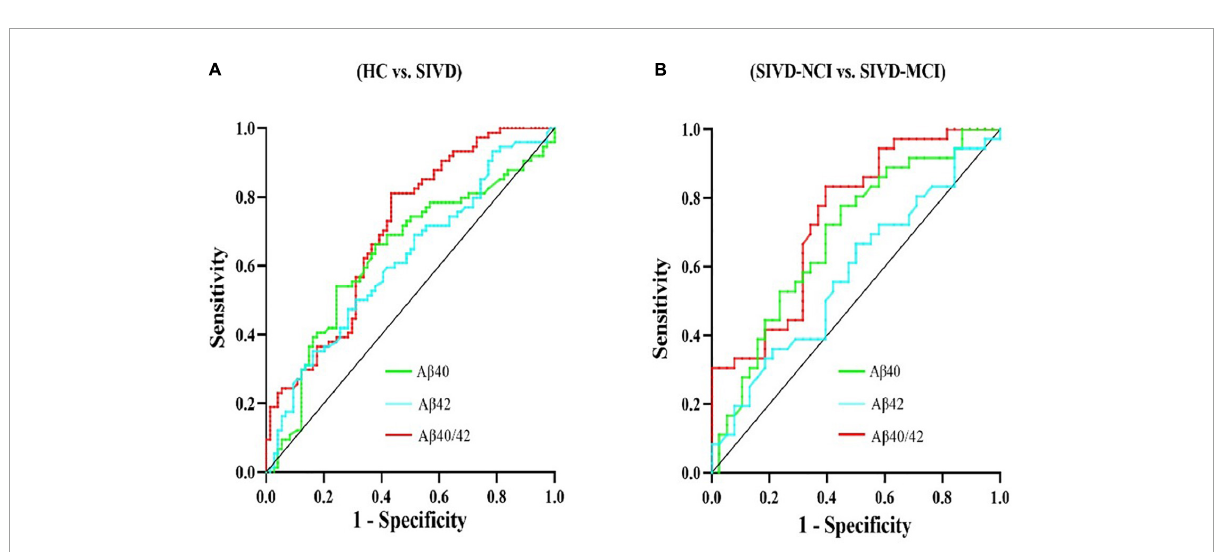
FIGURE2 ROC analysis of the serum A β 40, A β 42, and A β 40/42 ratio levels in the diagnosis of the SIVD and cognitive impairment. (A) ROC analyses of serum A β 40, A β 42, and A β 40/42 levels for SIVD patients versus HC. (B) ROC analyses of serum A β 40, A β 42, and A β 40/42 levels for SIVD-NCI versus SIVD-MCI. ROC, receiver operating characteristic; HC, healthy control; SIVD, subcortical ischemic vascular disease; NCI, no cognitive impairment; MCI, mild cognitive impairment; vs., versus.